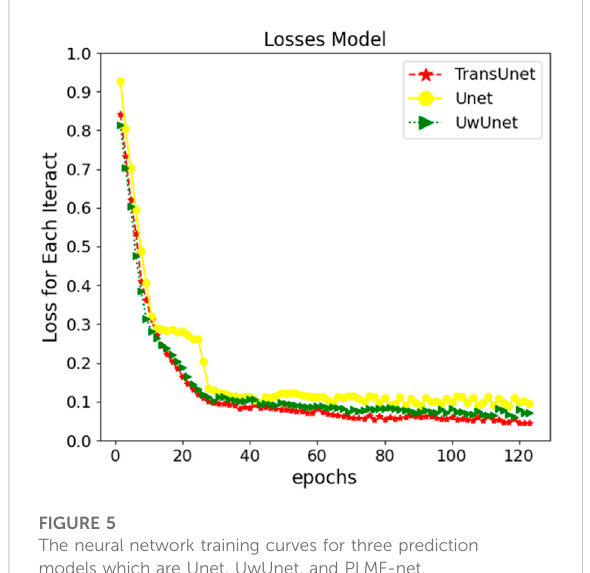
FIGURE 5 The neural network training curves for three prediction models which are Unet, UwUnet, and